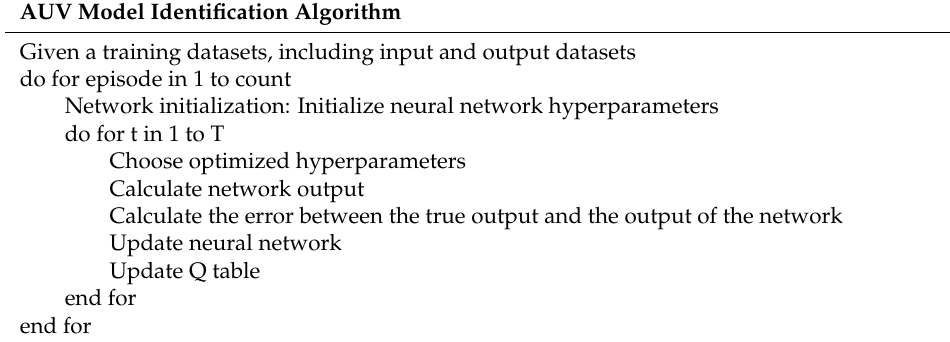
Table 3. AUV Model Identification Algorithm. AUV Model Identification Algorithm